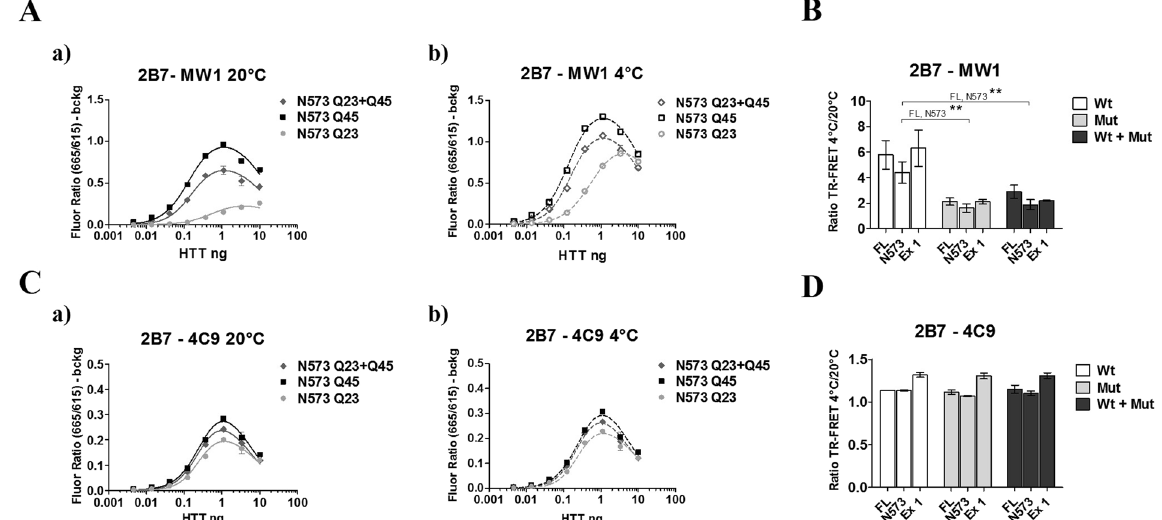
Figure 2. The 2B7/MW1 conformational immunoassay preferentially detects mHTT conformation in cocktails of isolated HTT proteins with wild type or mutant polyQ. ( A ) The 2B7/MW1 TR-FRET assay performed on wild type HTT, mHTT or a cocktail (of equivalent final protein concentration) of the two proteins at 20 °C (a) or measured after shifting the same samples to 4 °C (b). For simplicity, only results for a representative experiment performed on the N573 HTT protein fragments are shown. ( B ) Summary of data (ratio TR-FRET signals at 4 °C/20 °C) obtained on individual isolated HTT proteins (3 lengths, namely exon 1, N573 and full length) or cocktails of equivalent final protein concentration (Wt + Mut). ( C ) Same as A, obtained on the same proteins using a (control) TR-FRET immunoassay (2B7/4C9) which does not interrogate the polyQ region and does not detect a temperature- and polyQ dependent conformational change 11, 12 , demonstrating efficient detection of all proteins. ( D ) Same as B (ratio TR-FRET signals at 4 °C/20 °C) obtained on the same proteins using a (control) TR-FRET immunoassay (2B7/4C9) which does not interrogate the polyQ region and does not detect a temperature- and polyQ dependent conformational change. In (B and D) values represent means and standard deviations of the means of three independent experiments (two-way ANOVA with Bonferroni’s post-test, degrees of significance are